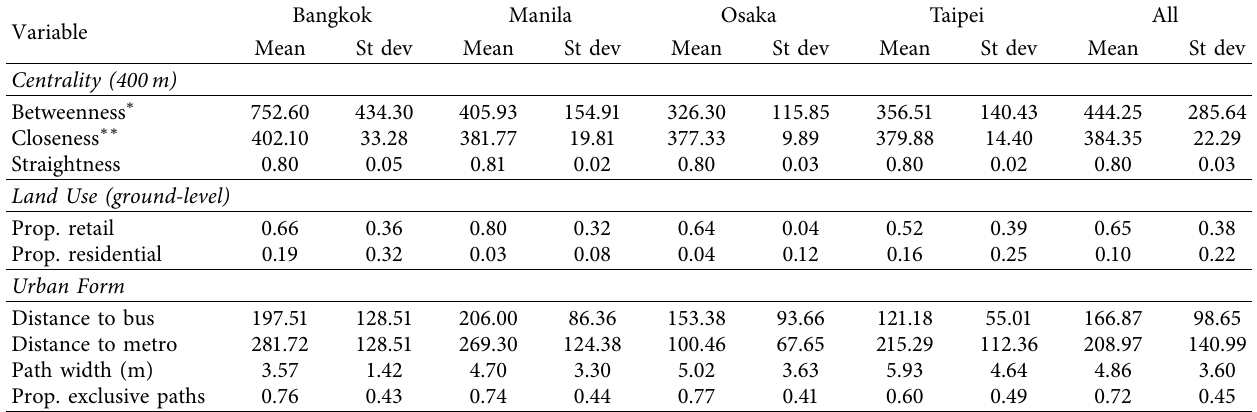
Table 3: Study site descriptive statistics (surveyed